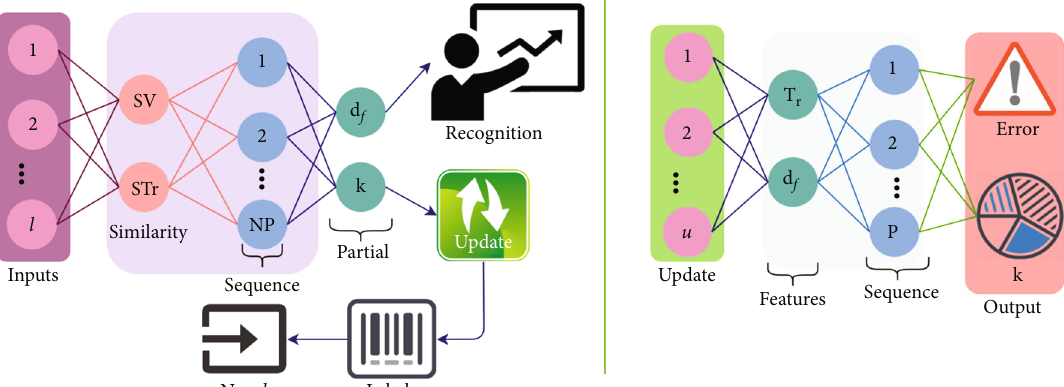
Figure 3: Learning process